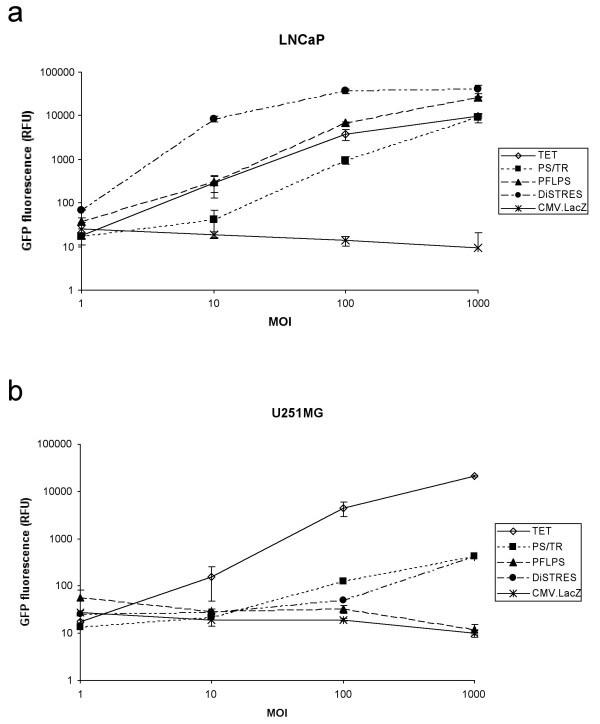
Ad/GFPDiSTRES demonstrates specificity for prostate cells, decreased activity in non-prostate control cells, and improves upon earlier vector designs. GFP fluorescence of (a) LNCaP cells and (b) U251MG cells. LNCaP and U251MG cells were seeded at 1.25 × 104 cells/well of a 96-well plate and infected with Ad/GFPTET, Ad/GFPPS/TR, Ad/GFPPFLPS, Ad/GFPDiSTRES, or Ad/C.LacZ (negative control) in the presence of 30 nM DHT at MOI 1, 10, 100, or 1000. 2 days post-infection, cell lysates were assayed for GFP fluorescence. RFU: relative fluorescence units. MOI values were based on IU/ml.